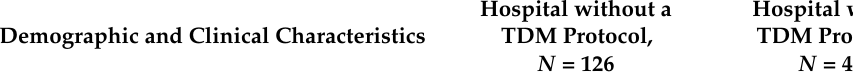
Table 1. Demographic and clinical characteristics of